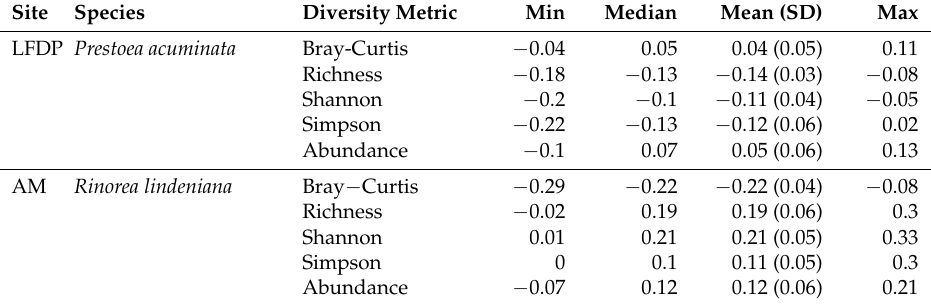
Table A4. Codispersion statistics for focal understory species in tropical forests (Figures